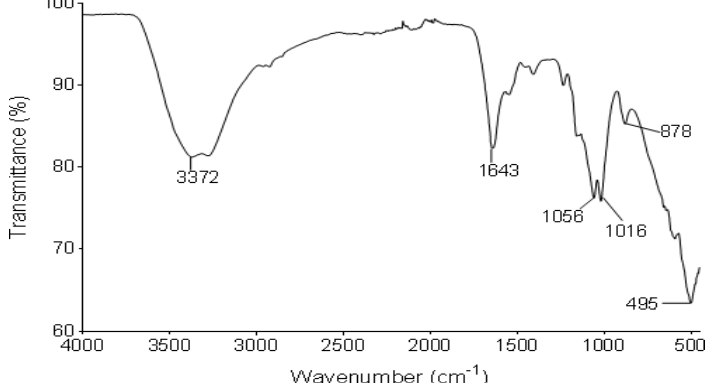
Figure 2. IR spectrum of the bioflocculant from B. subtilis CSM5.